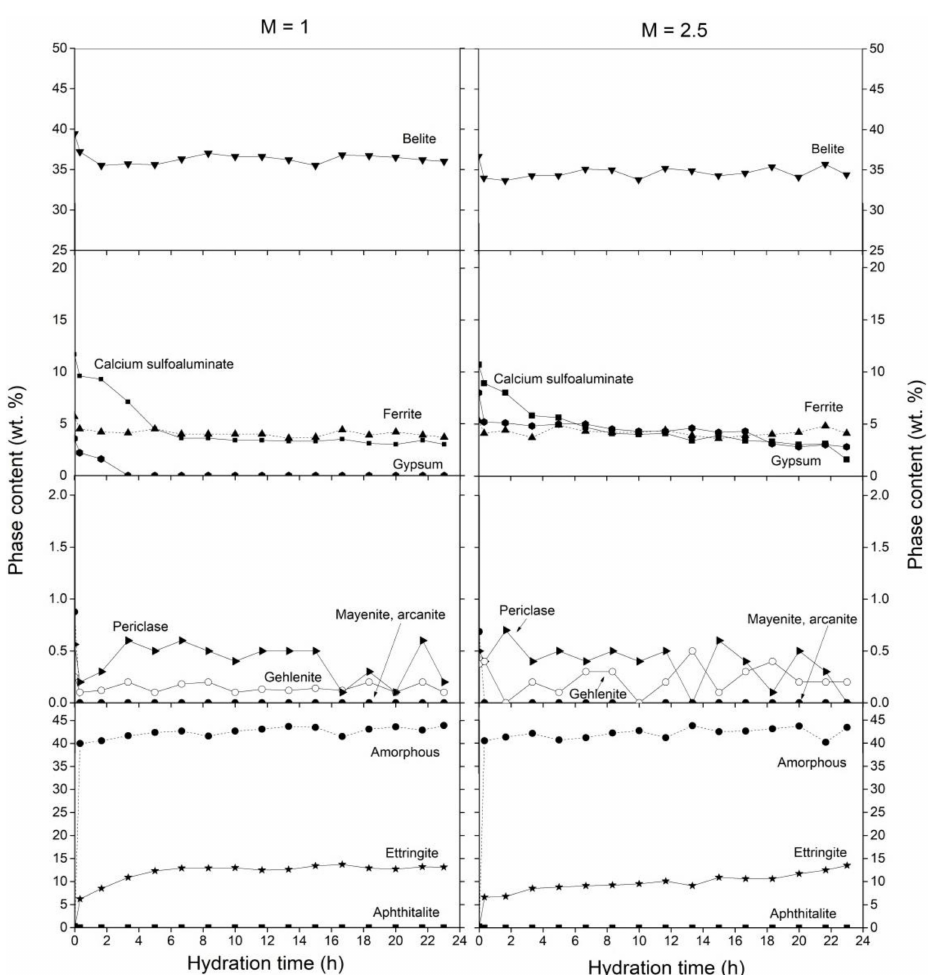
Figure 2. Phase content in the cement pastes with M = 1 and M = 2.5 cured at 25 ◦ C during the first 24 h of